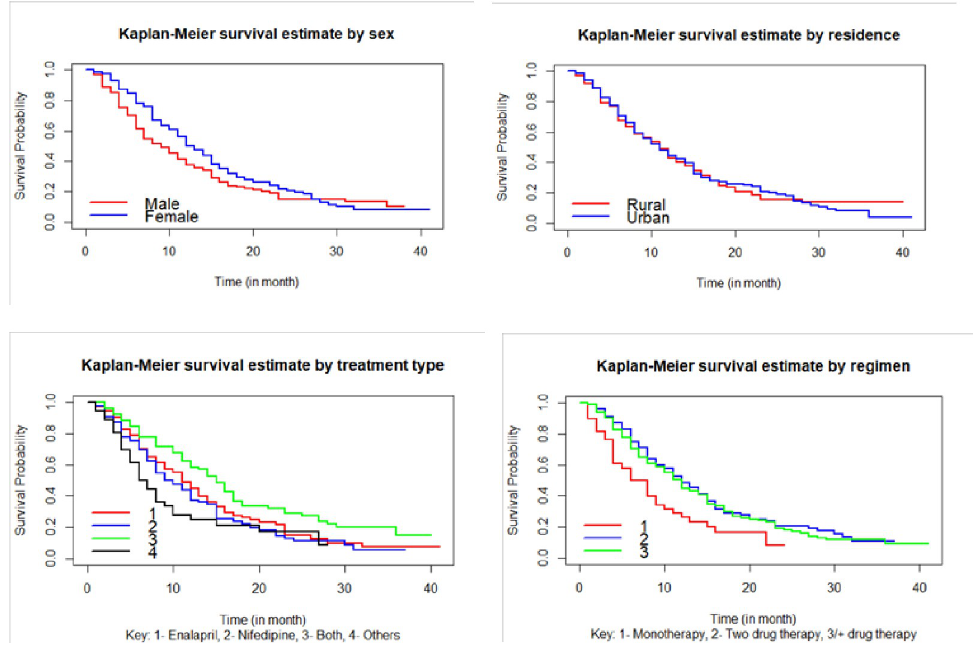
Fig 2. Kaplan-Meier plot for the survival function sex, residence, treatment type, and regimen.